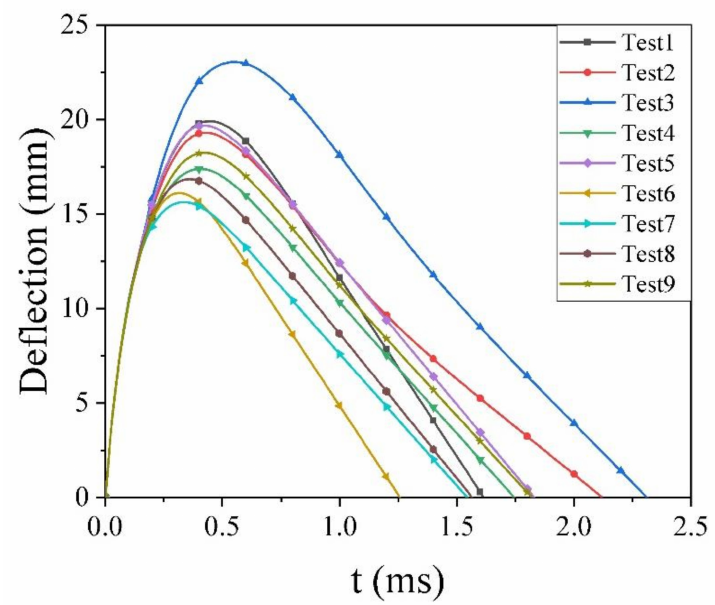
Figure 12. The deflection of GFRP laminates with varying layouts under the impact speed of 150